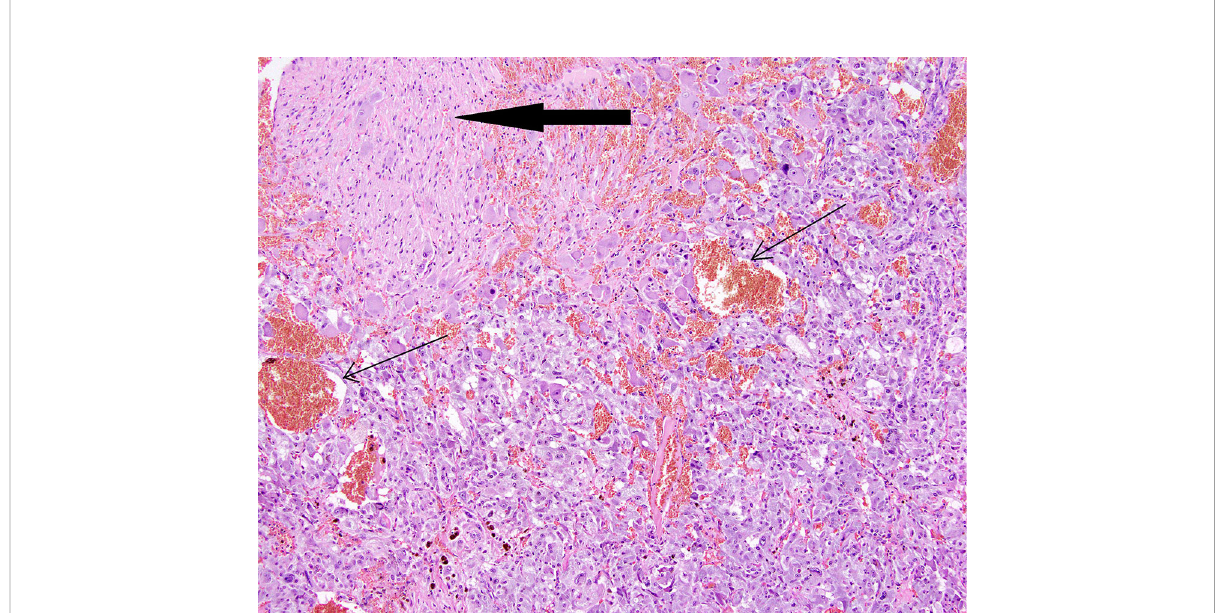
FIGURE 7 Patient number 3: composite pheochromocytoma and ganglioneuroma (ganglioneuroma component - thick arrow). Hemorrhages are present within pheochromocytoma tissue (thin arrows).